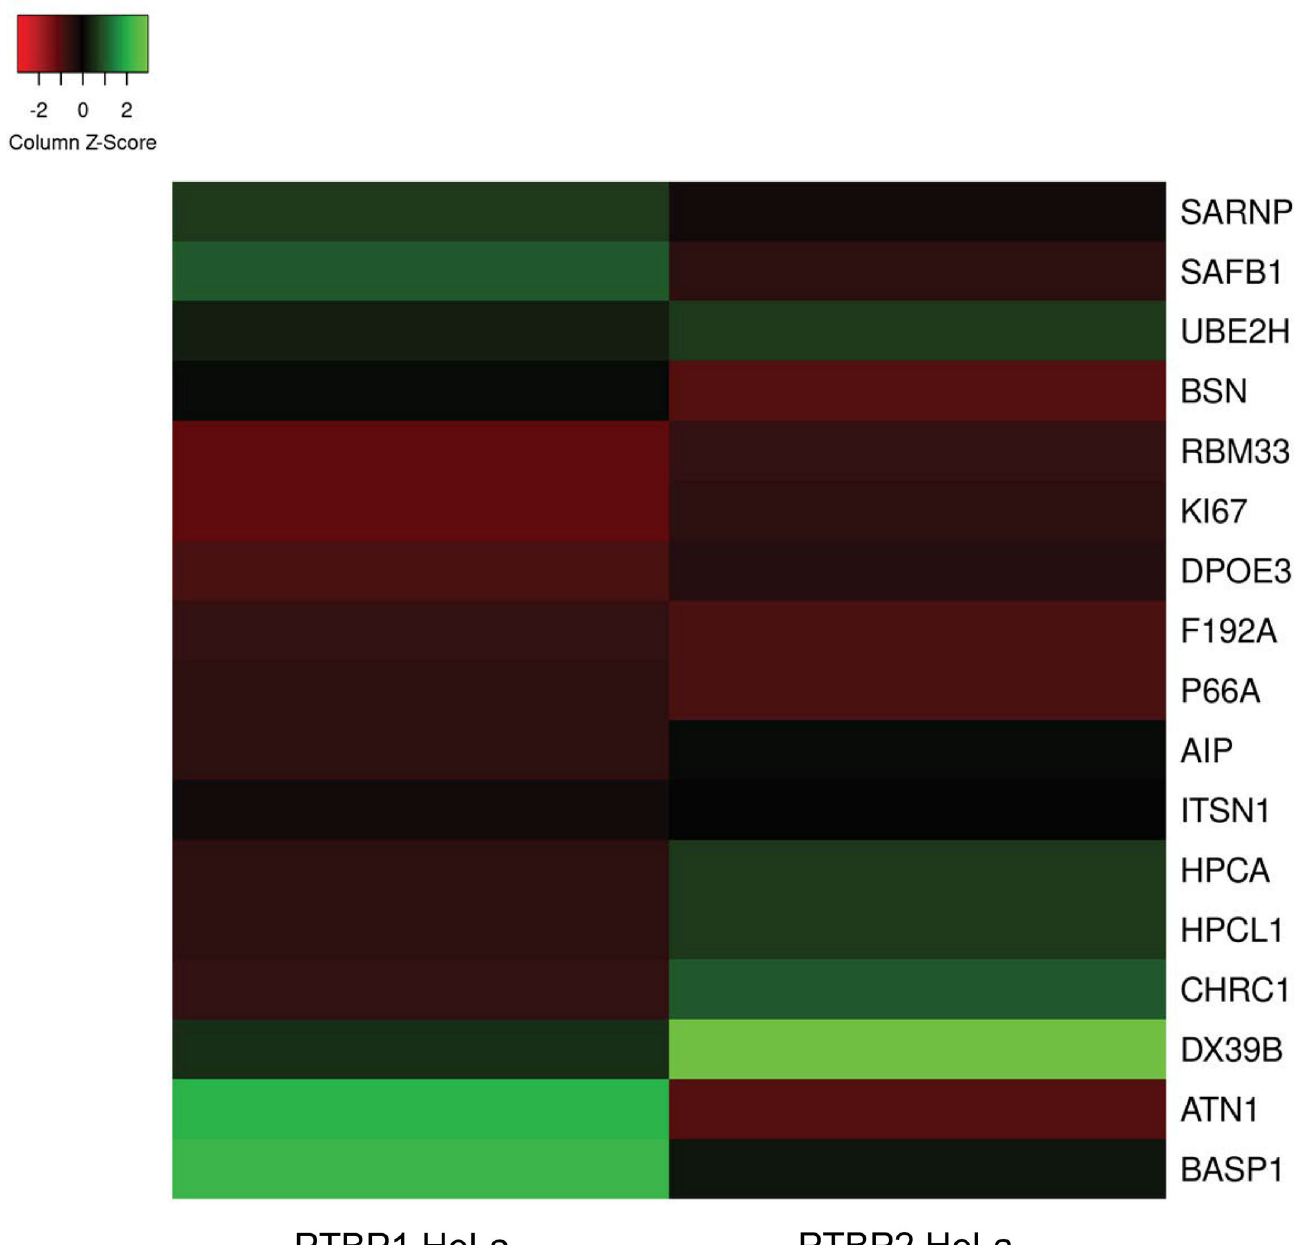
Fig 3. Heat map depicting the relative prevalence of the 17 proteins pulled down with both PTBP1 and PTBP2. The 0 baseline, indicated by black color shading, was determined by taking the average of the area scores for all 17 proteins. Proteins with a higher or lower area score than this average are shaded green or red respectively, with each point on the scale indicating the number of standard deviations from the baseline. This heat map was generated via heatmapper.ca [31]. https://doi.org/10.1371/journal.pone.0263287.g003 of proteins. Green and red bars (and corresponding intensities of those colors) indicate areas that are a standard deviation higher or lower than the mean respectively. In comparing the abundances, we note that SAFB1 and ATN1 are more prevalent in the presence of PTBP1 compared to PTBP2. SAFB1 is involved in chromatin binding and RNA/DNA binding. ATN1 is also involved in protein domain specific binding and plays a role in transcription co-